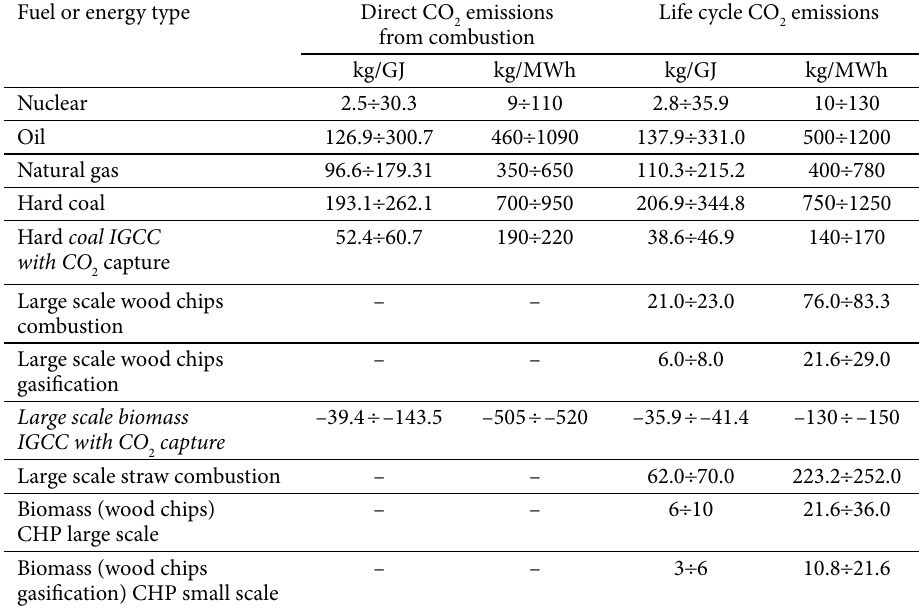
Table 1. Life cycle GHG emissions of the main energy technologies in power sector Fuel or energy